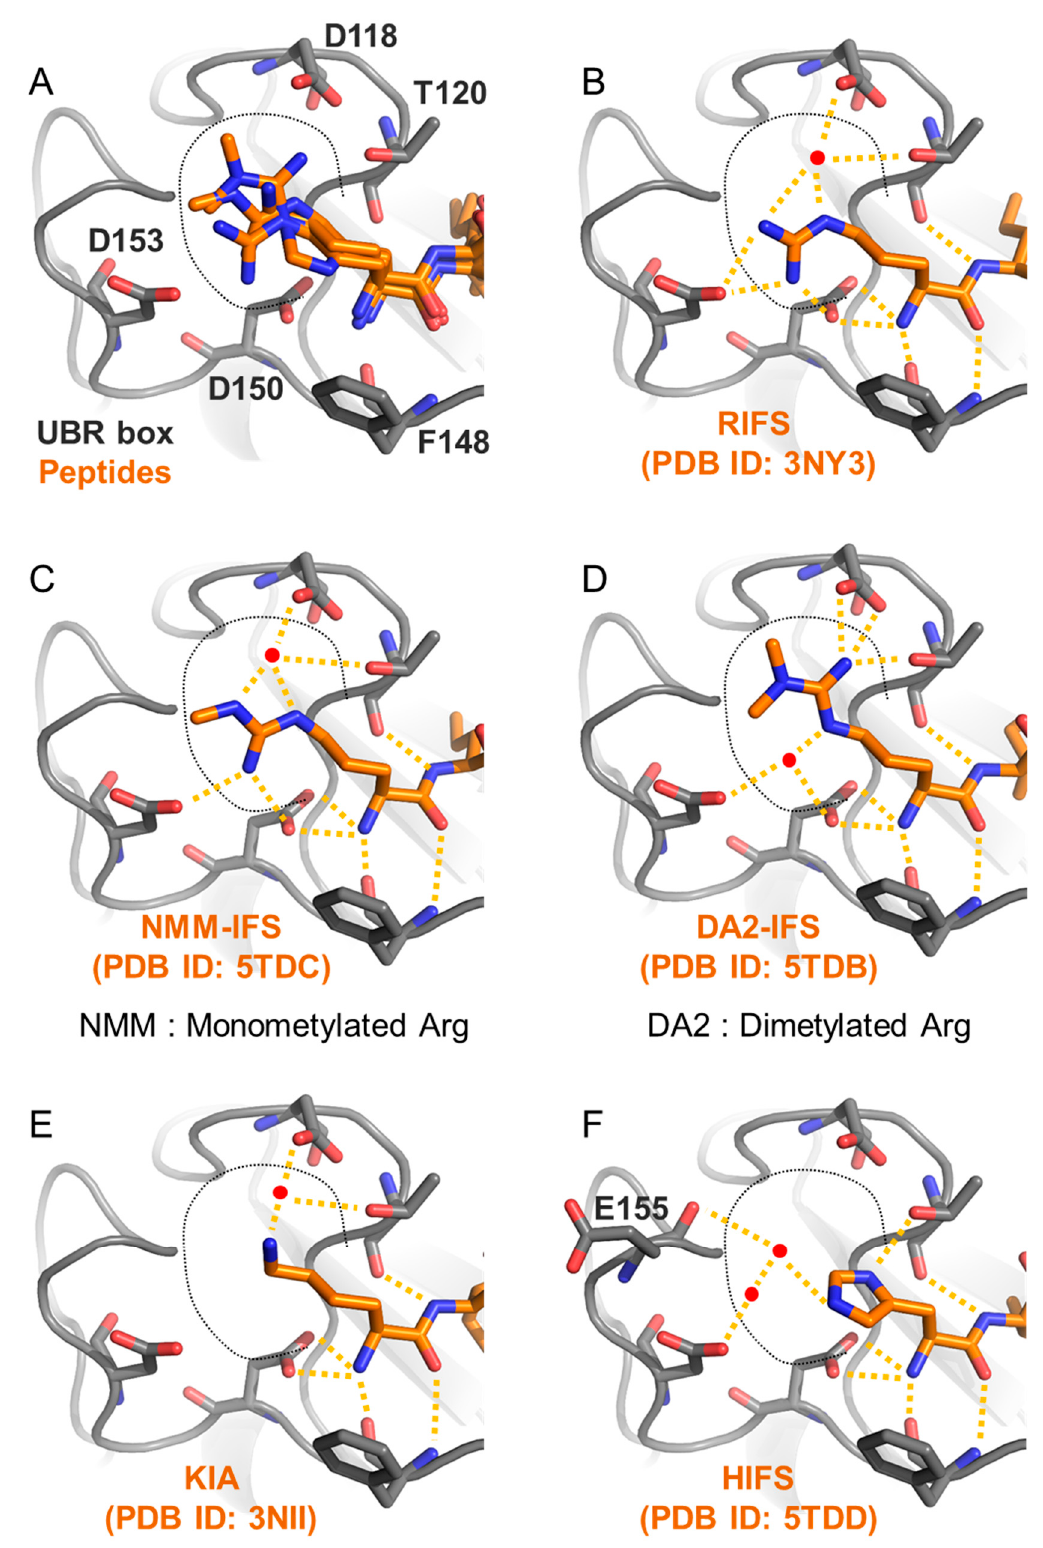
Figure 4. The first pocket of the UBR box recognizes the first residue of type 1 N-degrons. ( A ) Residues constituting the first pocket have enough space (black dotted line) for positively charged residues to enter. ( B – F ) Hydrogen bonding and charge–charge interactions (yellow dotted lines) generated when positively charged residues and modified arginine residues bind to the pockets, and water molecules (red dots) fill the empty spaces.